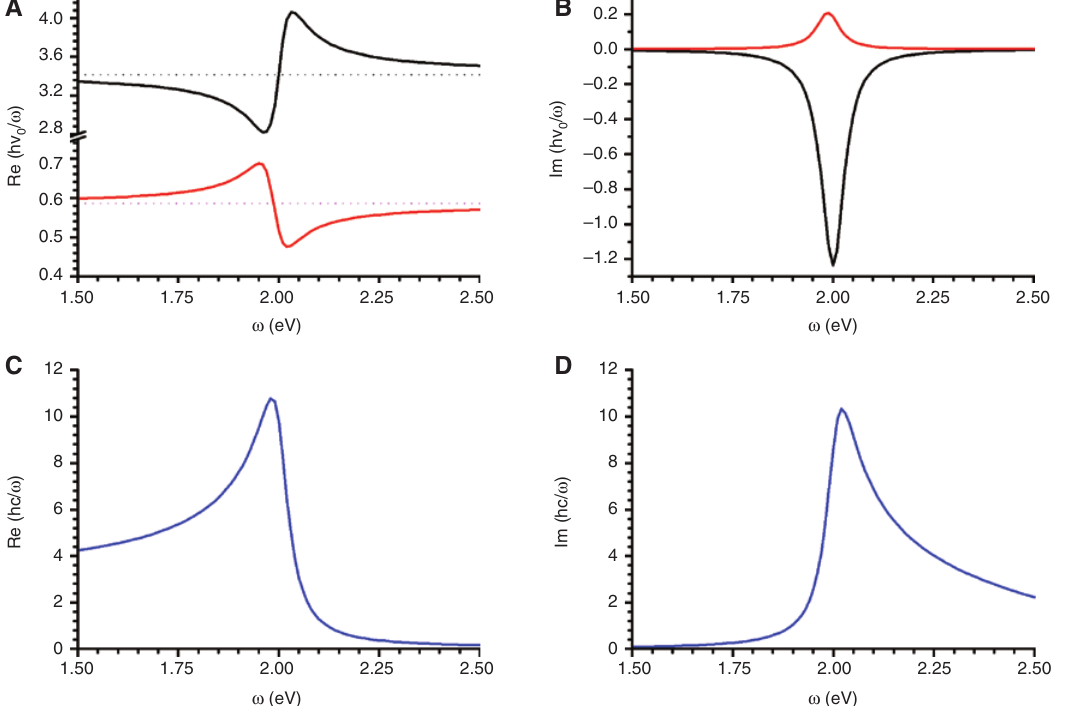
Figure 2: The dispersion characteristics of the slow collective dissipative modes. The modes are either slow with respect to the 2D electron drift velocity (black curves) or fast with respect to v (red curves). (A) the 0 normalized (by ω / v ) wavenumber and (B) the instability increment vs frequency. Slow mode exhibit amplification (negative increment) 0 while the fast mode is decaying. Dotted lines in (A) corresopond to oscillations in recluse current-carrying QW. The dispersion characteristic of the conventional SPP mode is shown in (C) and (D), the normalized (by ω / c ) wavenumber and the damping coefficient vs frequency, = 10 12 cm −2 , a gold film and a drift velocity equals to the Fermi respectively. Calculations are made for an InGaAs quantum well with n 0 = v ≈ 4.3 × 10 7 cm s − 1 velocity of 2D electron liquid, v 0 F